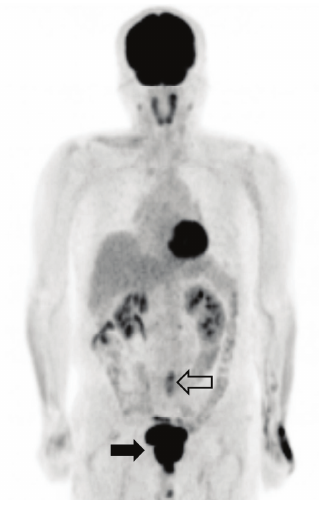
Figure 4: Coronal FDG PET image performed after surgery shows no abnormal uptake suggesting malignancy or metastatic tumor in the body except intense uptake due to prostate cancer and urine in the pelvis (solid arrow) and shows focal increased uptake due to postoperative change in L4/5 level (open